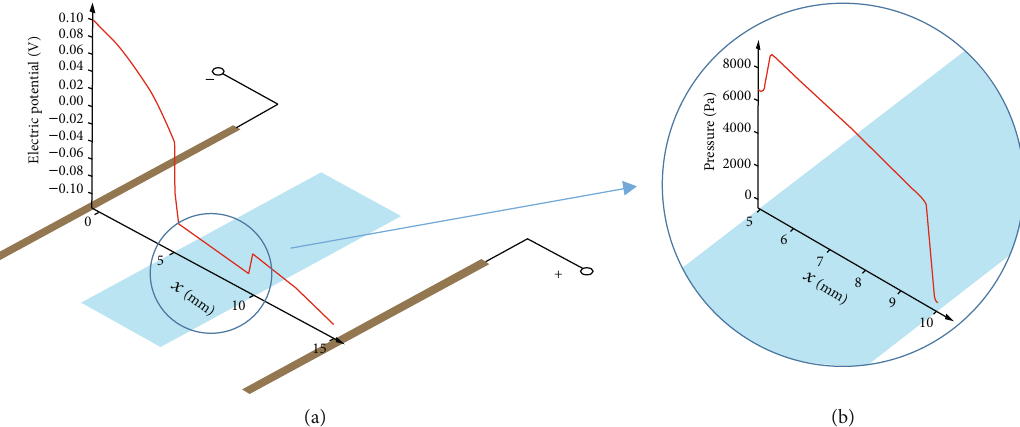
Figure 5: (a) The electric potential distribution of the hydrogel under an external electric fi eld. (b) The corresponding pressure distribution of the